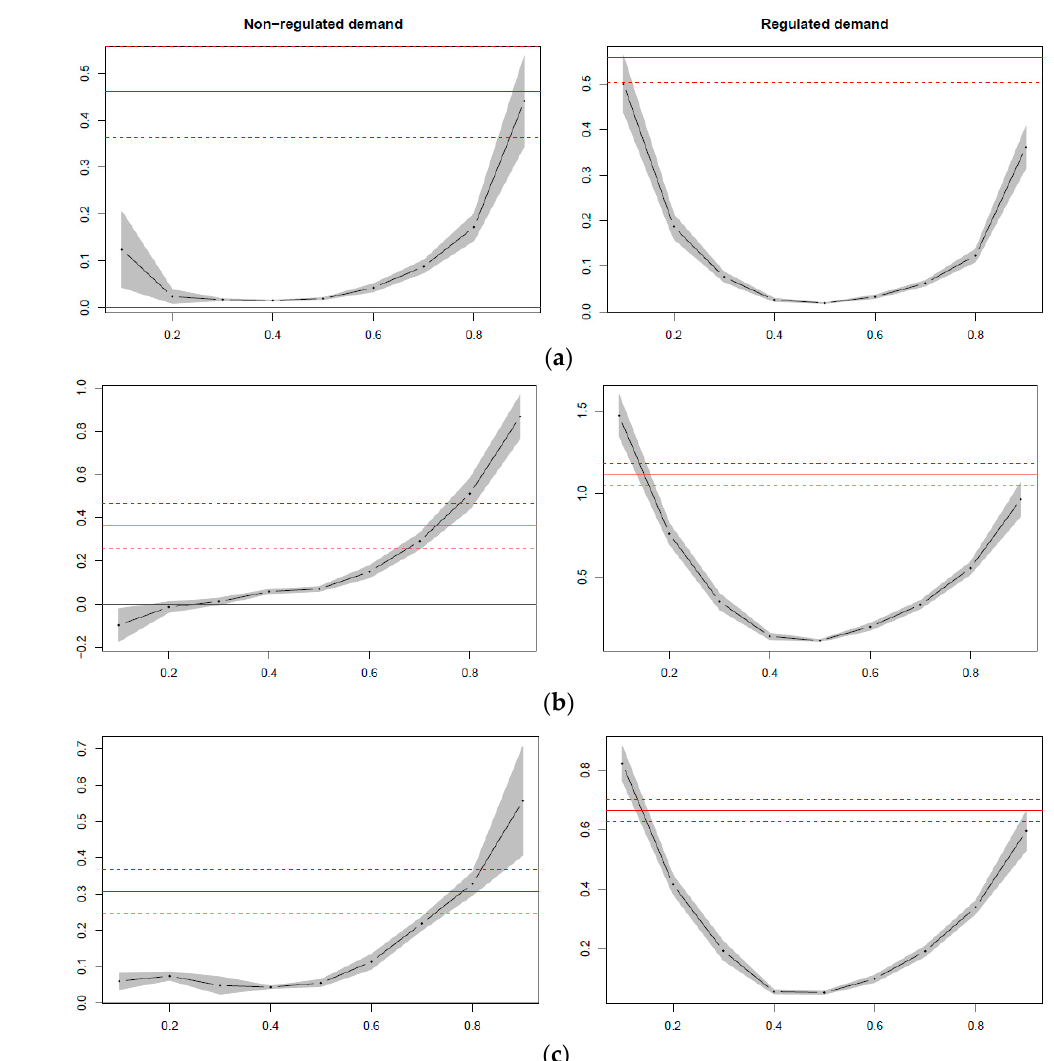
Figure 4. Non-regulated and regulated demand effects on the electricity spot price for different percentiles and for February–September of 2018–2019–2020. The variables are defined as follows: ( a ) effects of the non-regulated and regulated demand in 2018; ( b ) effects of the non-regulated and regulated demand in 2019; ( c ) effects of the non-regulated and regulated demand in 2020. The vertical axis in each subplot corresponds to the spot price response by effects of the demand variables, and the horizontal axis corresponds to each percentile. The dotted black lines represent the quantile regression coefficients, and the gray shaded area is the 95% confidence interval. The continuous red line is the linear regression coefficient estimated by OLS, and the discontinuous red lines are the 95% confidence intervals.